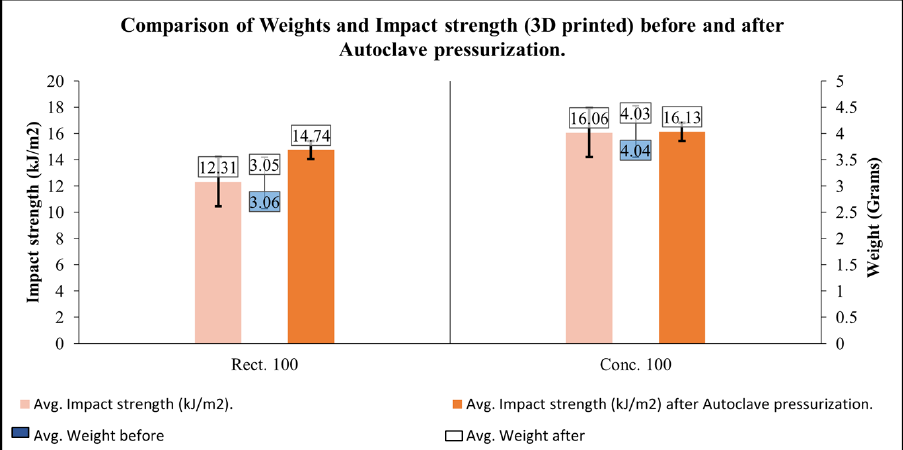
Figure 18. Comparison between weights and impact strength of PLA 3D-printed samples before and after autoclave pressurization.